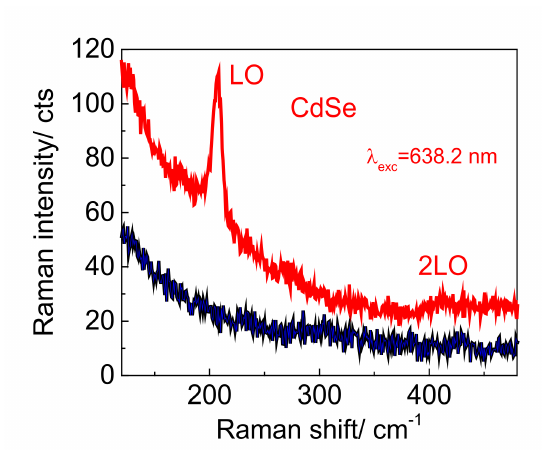
Figure 7. SERS spectra of CdSe NC monolayer measured on a Klarite substrate and on the flat gold, red and blue curves,